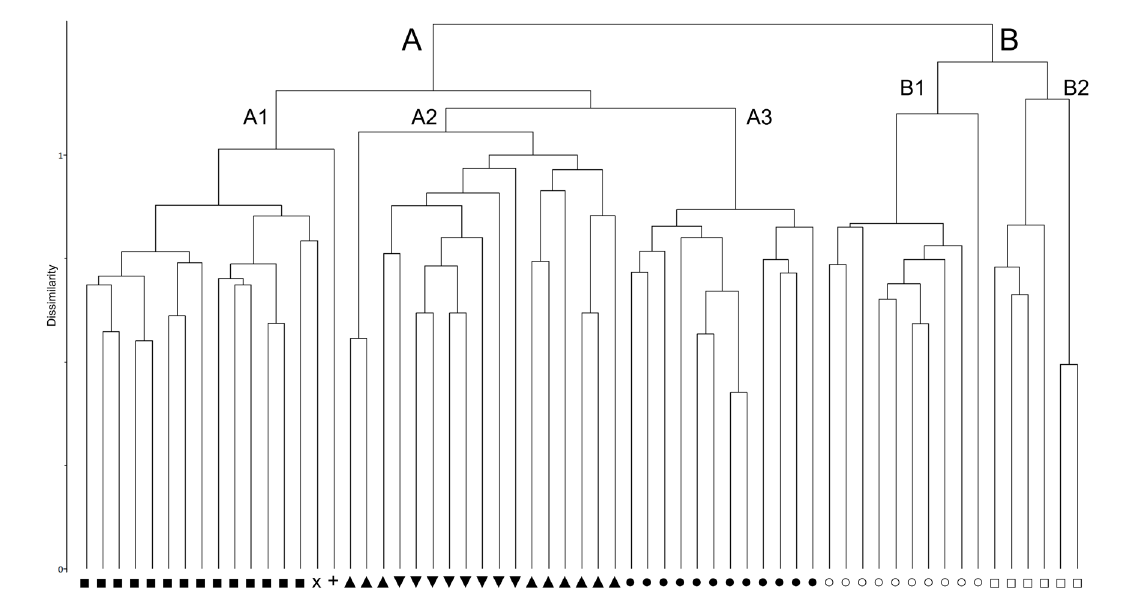
Figure 6. Cluster analysis of relevés of meadows from NE Italy lowlands (cover data, Chord distance, UPGMA). ■ , Leucojo-Poetum pratensis (Tasinazzo 2009); ▲ , Poo-Lolietum multiflori leucojetosum aestivi (Poldini and Oriolo 1995); ▼ , Poo-Lolietum multiflori brometosum hordeacei (Poldini and Oriolo 1995); ● , Centaureo-Arrhenatheretum elatioris (Poldini and Oriolo 1995, rels 1 – 12); ○ , Plantagini-Molinietum caeruleae (Marchiori and Sburlino 1982); □ , Serratulo-Plantaginetum altissimae (Poldini 1989); ×, flooded meadow from Doberdò; +, flooded meadow from Palù.